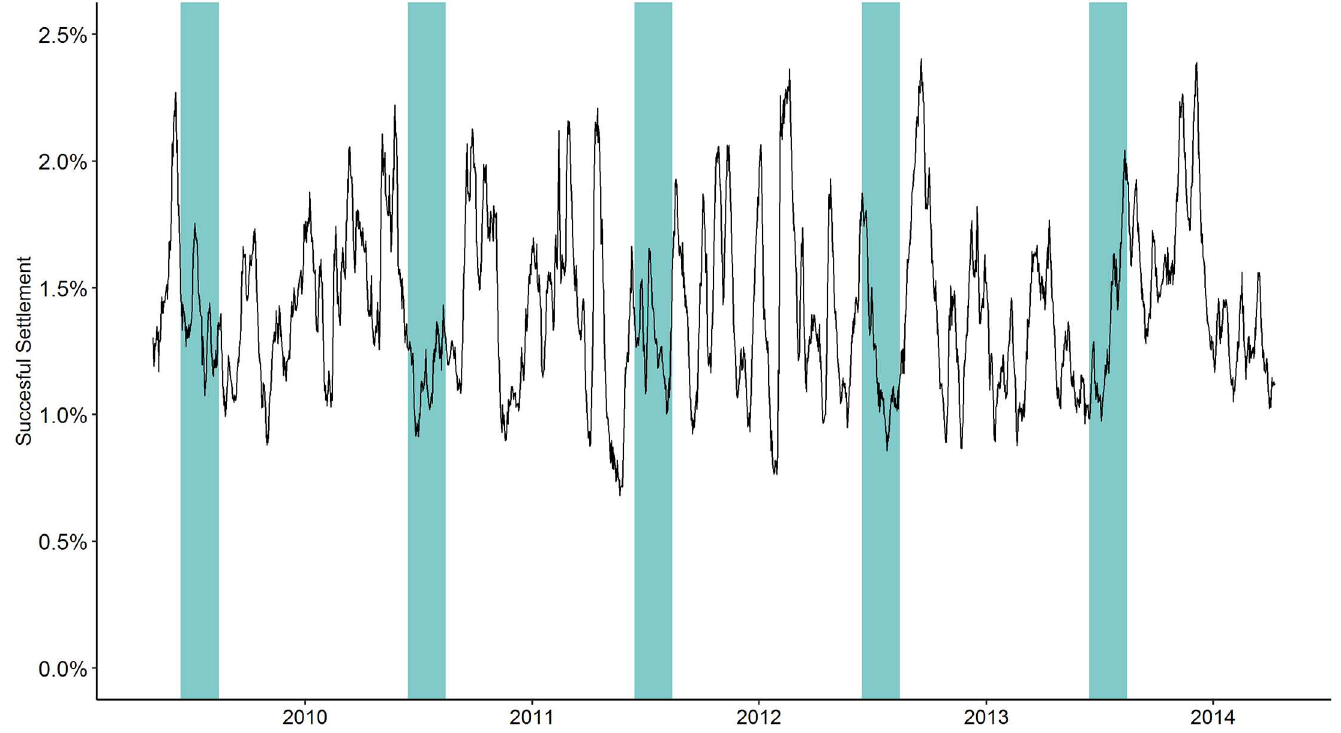
Fig 3. Total percent successful settlement for all sites in the Hawaiian Archipelago for the five-yearmodel run. The green bars represent particles spawnedduringpeak spawningseason May-June each